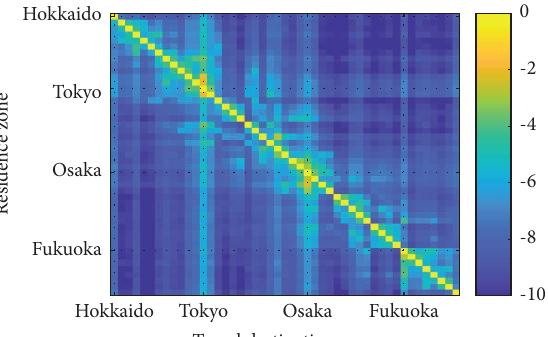
Figure 4: Estimated matrix ( A